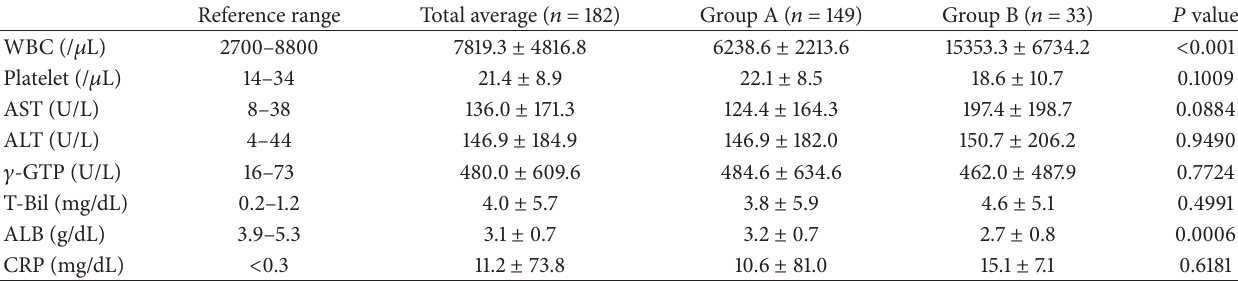
Table 2: Laboratory examination data of Group A and Group B.